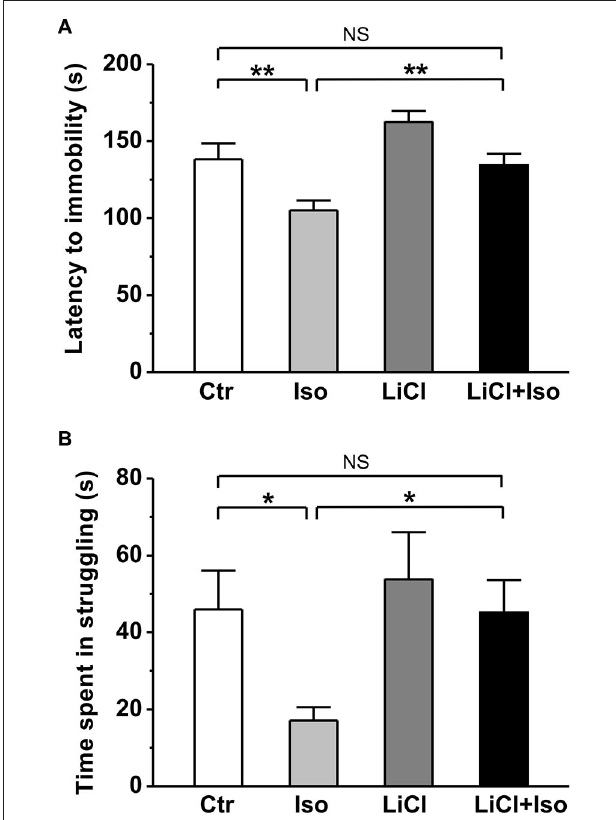
FIGURE 5 | Lithium reduces depressive-like behavior in neonatal isolation rats . In forced swimming paradigm, both latency to immobility (A) and struggling time during the last 4 min (B) are significantly reduced in isolated rats compared to control, and lithium treatment recovers the impairment. Two-way ANOVA analysis was used in this experiment. For latency to immobility: treatment × drug, F ( 1,95 ) = 9.779 P < 0.05; treatment, F ( 1,95 ) = 19.003, P < 0.05; drug, F ( 1,95 ) = 3.473, P > 0.05. For time in struggling: treatment × drug, F ( 1,95 ) = 1.178, P > 0.05; treatment, F ( 1,95 ) = 3.968, P < 0.05; drug, F ( 1,95 ) = 3.648, P > 0.05. Data show mean ± SEM (* p < 0.05; ** p < 0.01).